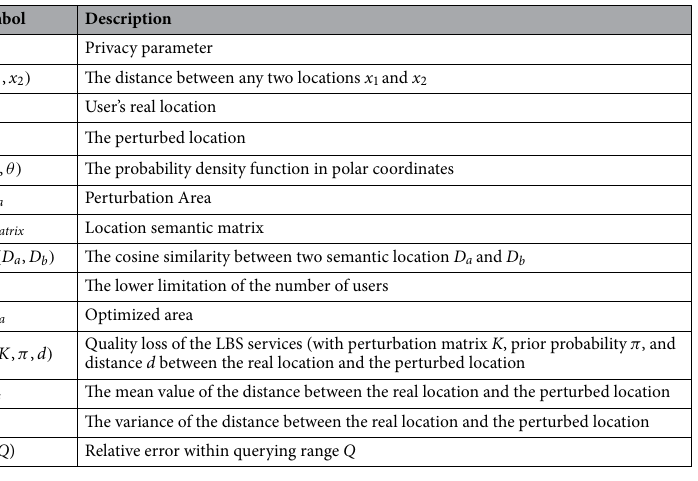
Table 1. Mathematical